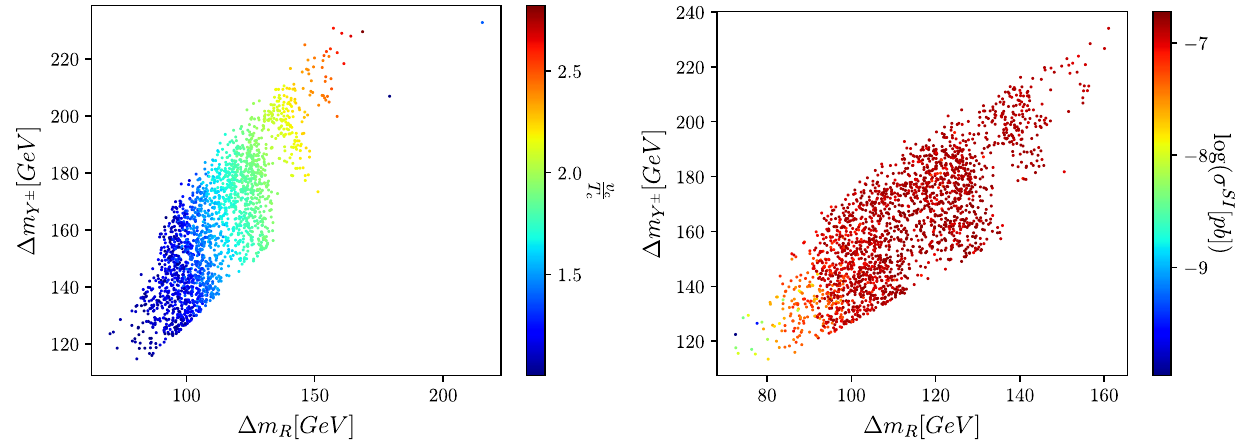
Fig. 2 Scatter plots showing the correlations between the inert scalars’ mass differences with: (left) strength of the first-order EWPT, v c (right) the inert single DM candidate particle’s elastic scattering cross